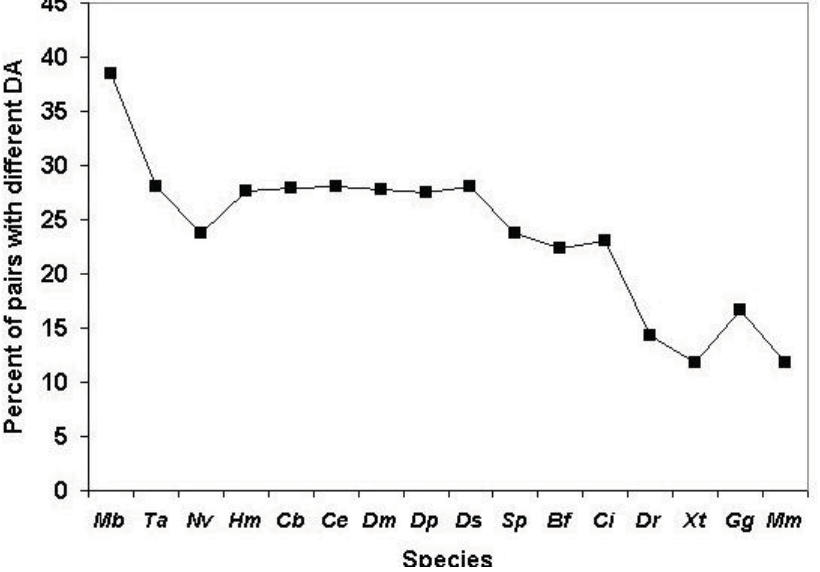
Figure 11. Analysis of the DA of paralogous clusters of human Swiss-Prot proteins defined through comparison with RefSeq proteomes of various species. The ordinate shows the proportion of pair-wise comparisons within clusters where the pairs differ in DA. On the abscissa the species are listed in the order of decreasing evolutionary distance from Homo sapiens , thus the abscissa has a time-dimension but their distance is not drawn to scale. Note that there is a significant drop in the proportion of pairs that differ in DA at the boundary of the invertebrate/vertebrate transition. Abbreviations on the abscissa: Ta - Trichoplax adhaerens, Nv - Nematostella vectensis, Hm - Hydra magnipapillata, Ce -Caenorhabditis elegans, Cb -Caenorhabditis briggsae, Dm -Drosophila melanogaster, Dp -Drosophila pseudoobscura, Ds - Drosophila simulans, Sp - Strongylocentrotus purpuratus, Bf - Branchiostoma floridae, Ci - Ciona intestinalis, Dr - Danio rerio, Xt - Xenopus tropicalis, Gg - Gallus gallus, Mm - Mus